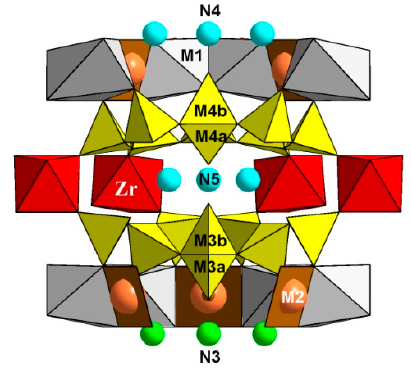
Figure 7. A fragment of the crystal structure of davinciite.